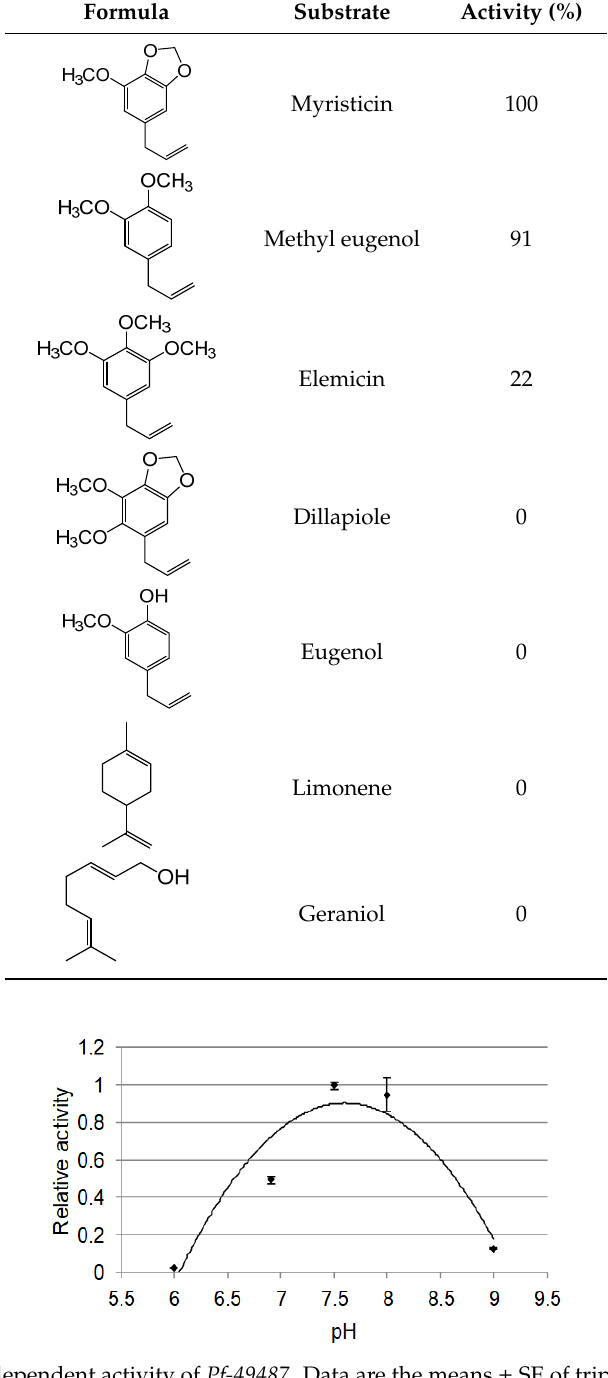
Figure 7. pH-dependent activity of Pf-49487 . Data are the means ± SE of triplicate analyses.